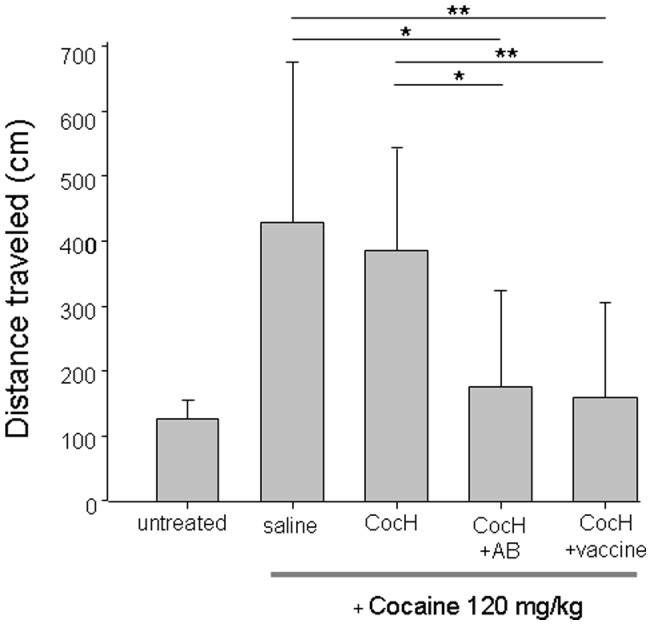
Combined anti-cocaine antibody and cocaine hydrolase block mouse locomotor stimulation by high-dose cocaine.Untreated mice were given only i.p. saline. All others received cocaine, total of 120 mg/kg i.p., in two 60 mg/kg doses 10 min apart. CocH groups received enzyme, 1 mg/kg, i.p. AB mice received anti-cocaine antibody, 16 mg/kg i.p. “Vaccine" mice were each immunized with 100 µg of norcocaine-conjugate cocaine vaccine, and a booster immunization at 3 weeks. Statistical significance (n = 8 for all groups): * p<0.05; ** p<0.01).